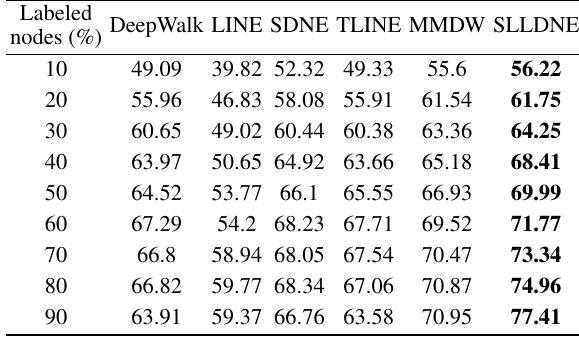
Table 3 Micro-F1 (%) of vertex classification on CiteSeer.